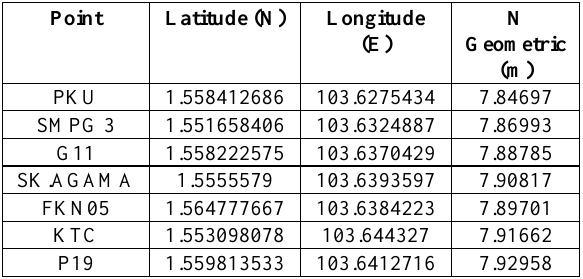
Table 10. The positions and value of N geometric for external accuracy points.